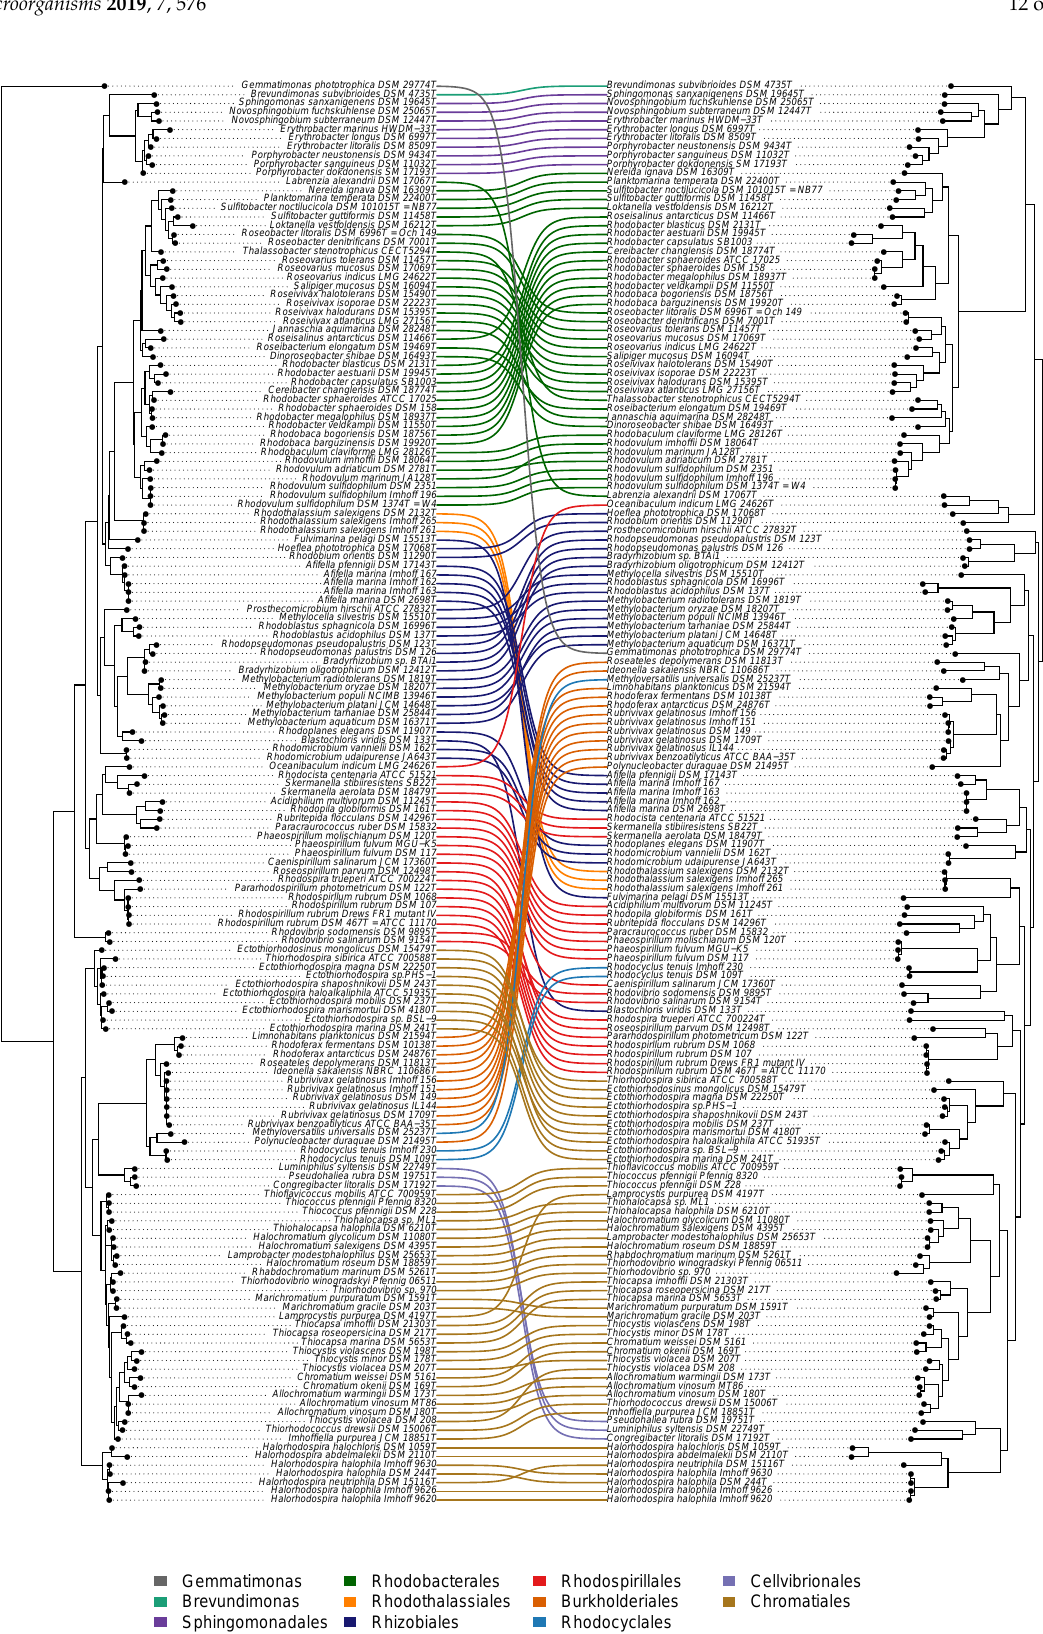
Figure 4. Linear comparison tree of 16S rRNA gene sequences (right) and BchXYZ-PufHLM sequences (left) of phototrophic